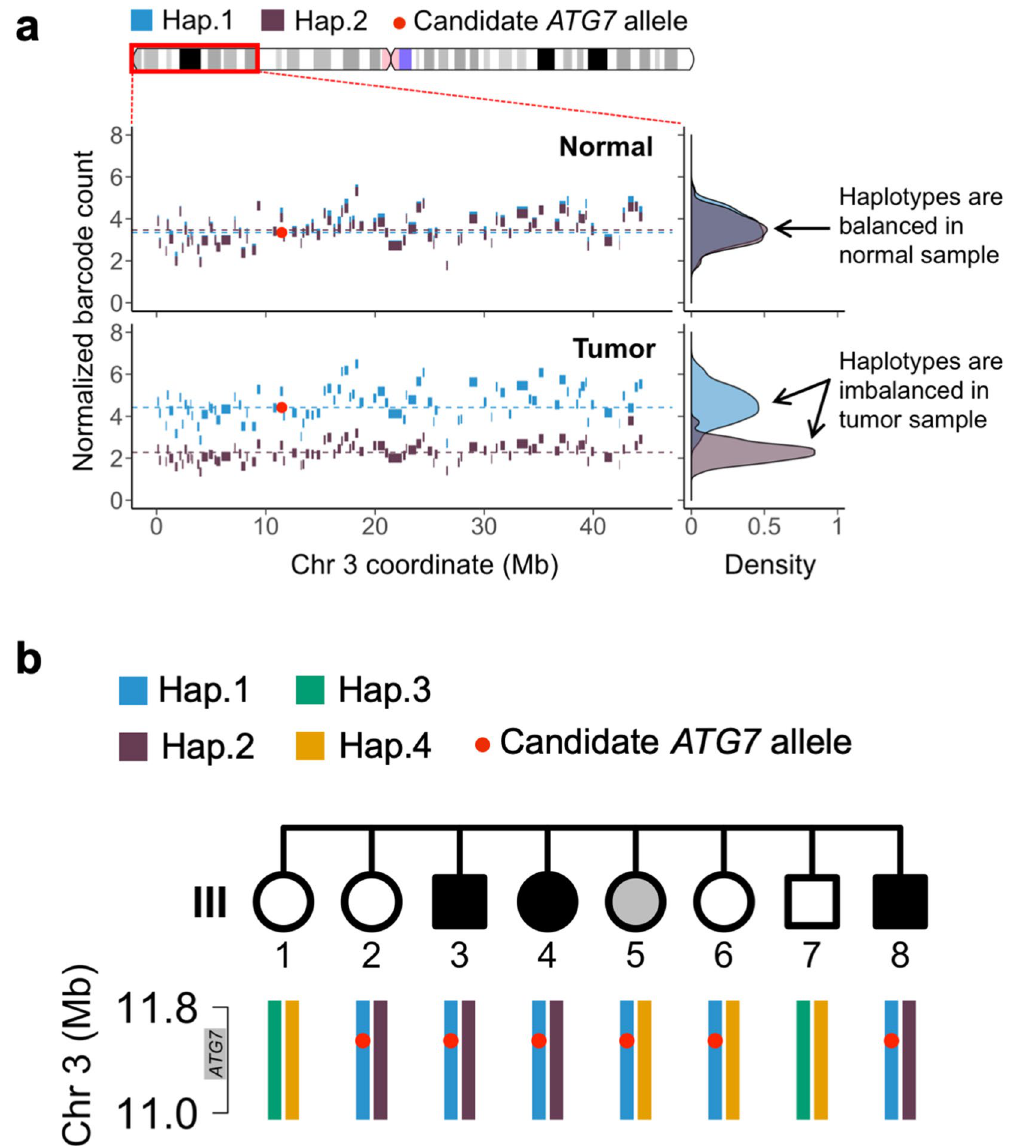
Figure 2. Haplotype analysis of the candidate ATG7 allele (p.R659*). ( a ) Extended haplotype of the 45 Mb deleted region of chromosome 3p in individual III:8. The blocks indicate the original fragmented haplotypes, and their color denotes their subsequent assignment to haplotypes covering many Megabases. The candidate ATG7 allele exists in haplotype 1 (blue), which was the non-deleted haplotype in the tumor of this individual. ( b ) Germline haplotype analysis of siblings for the ATG7 genomic region. The haplotype segregation across all eight siblings in generation III was determined for the 0.8 Mb genomic region surrounding the ATG7 allele (red dot). The candidate ATG7 allele exists in haplotype 1 (blue).